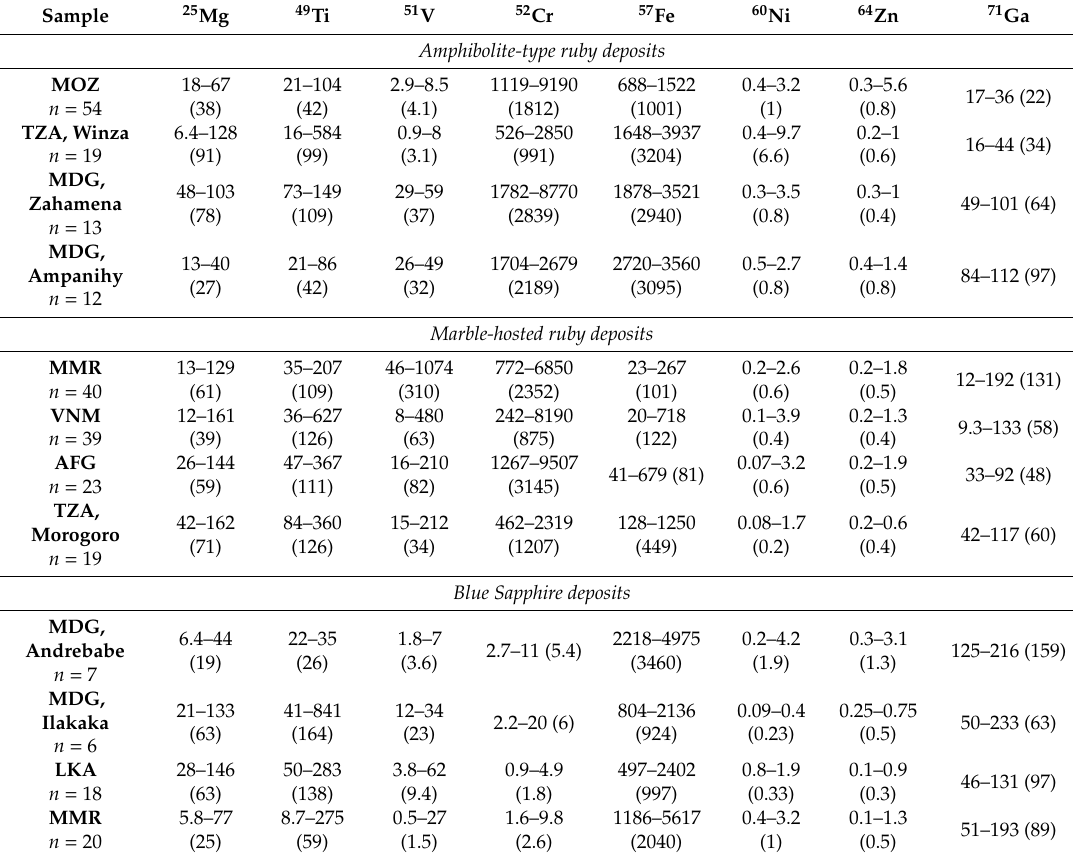
Table 3. Trace element comparative ranges with medians in parentheses. All data are in ppm ( µ g /